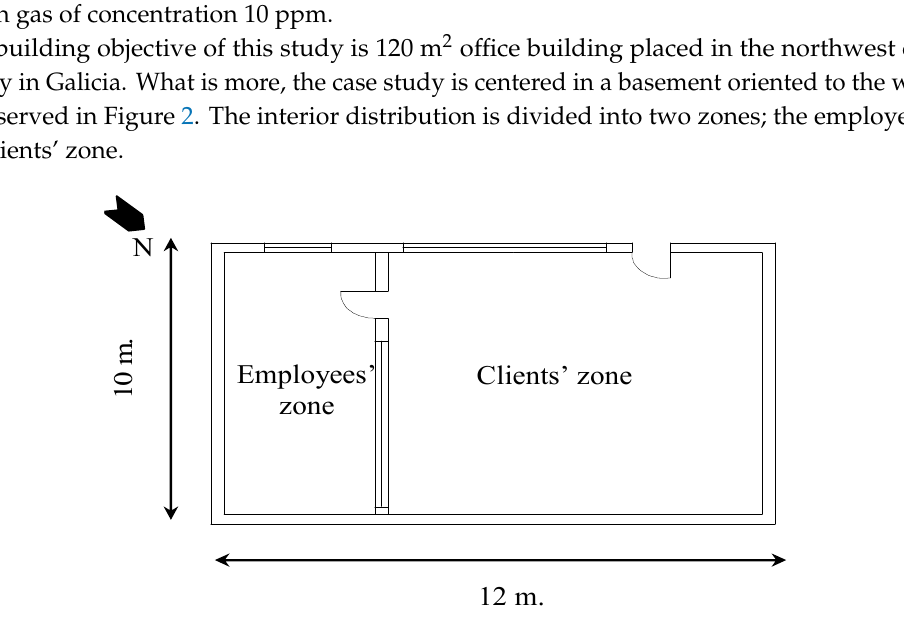
Figure 2. Office building distribution used in this study.